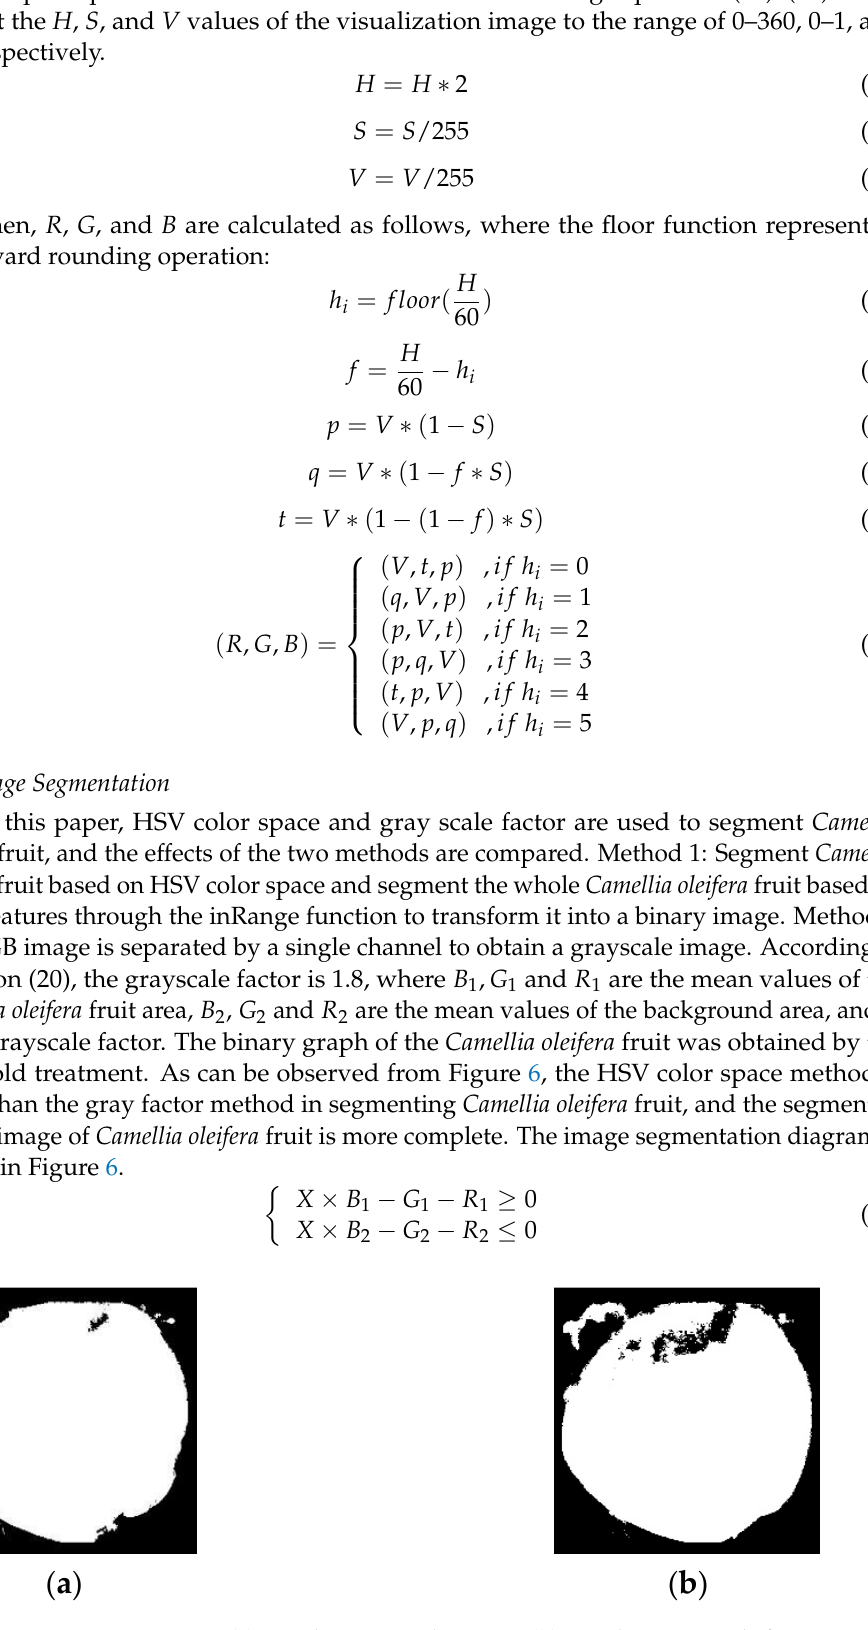
Figure 6. Image segmentation. ( a ) Based on HSV color space, ( b ) Based on gray scale factor.